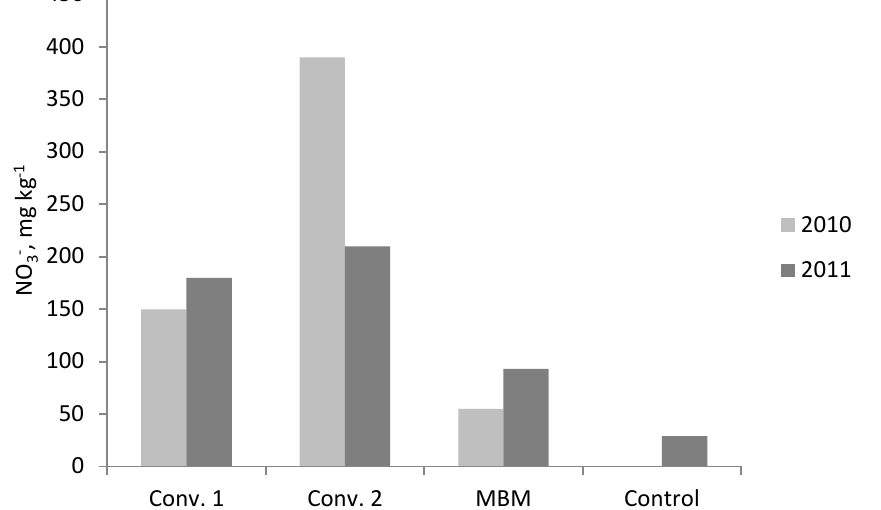
Fig. 5. Nitrate content in carrot fertilized by conventional mineral (Conv.) or by MBM fertilizers. For details of the fertilizers see Table 8. Unfertilized control was included in the 2011 trial